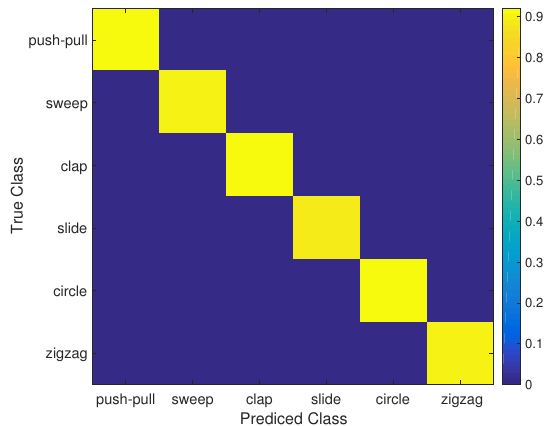
Figure 6. Confusion matrix of different